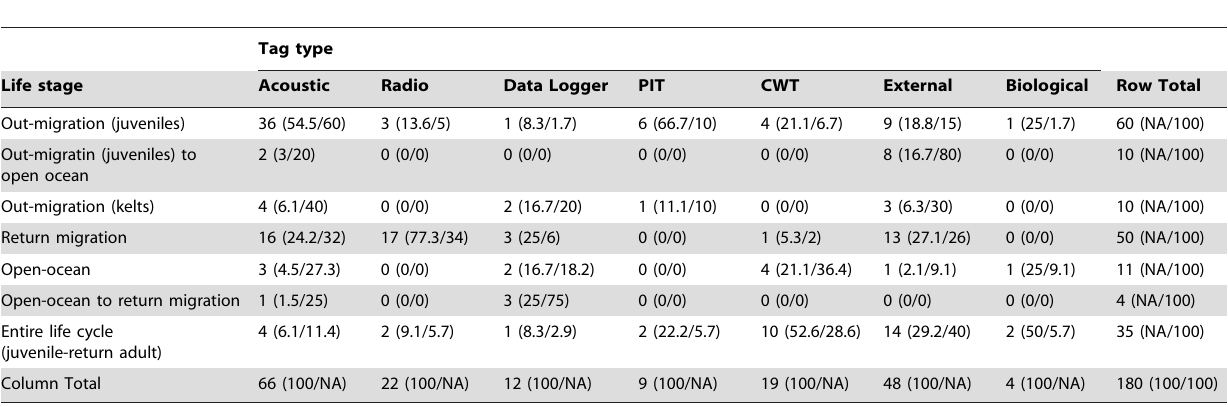
Table 2. Frequency (% within parentheses) of use of different tag types to study the life stages of anadromous salmonids in the marine environment for studies focusing on behaviour (i.e. those focusing on only behaviour and both on behaviour and